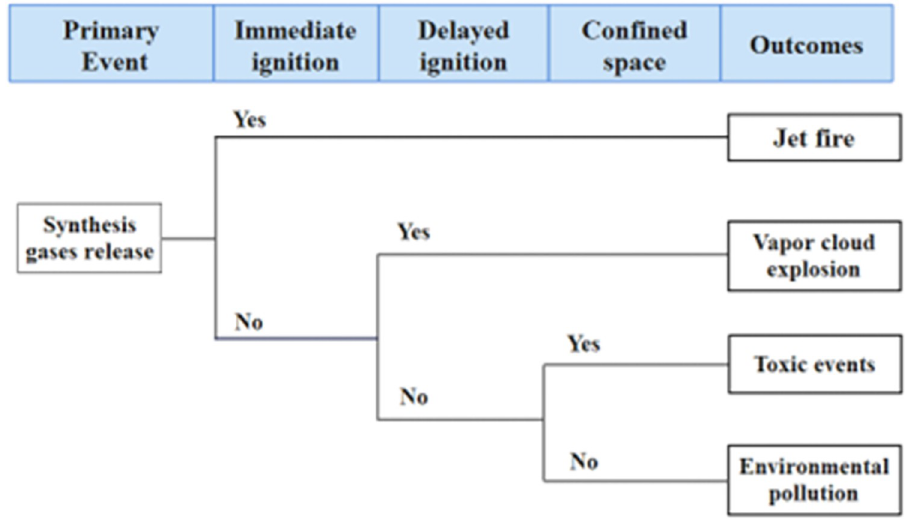
Fig 2. Event tree analysis of fire or explosion in the coal gasification